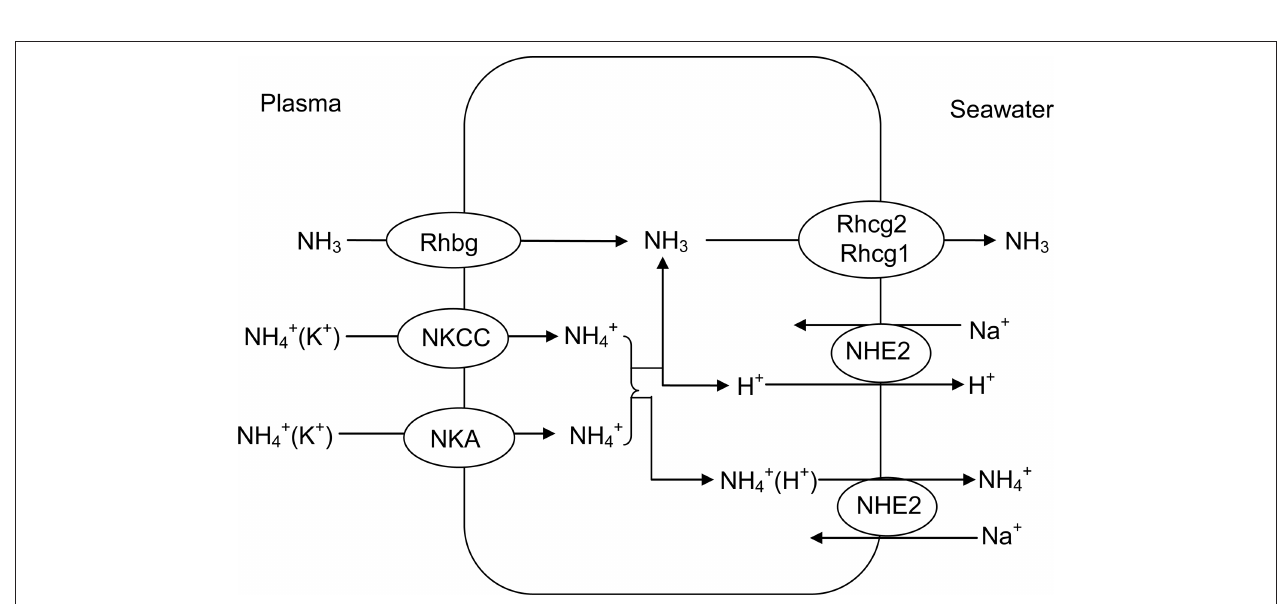
Figure 4 | The roles of rhesus glycoproteins (rhbg, rhcg), in conjunction with those of Na + /K + -ATPase (NKA), Na + /H + exchanger 2 (NHe2), Na + /H + exchanger 3 (NHe3), and proton-ATPase (H + -ATPase), in ammonia excretion through the gills of freshwater fishes.